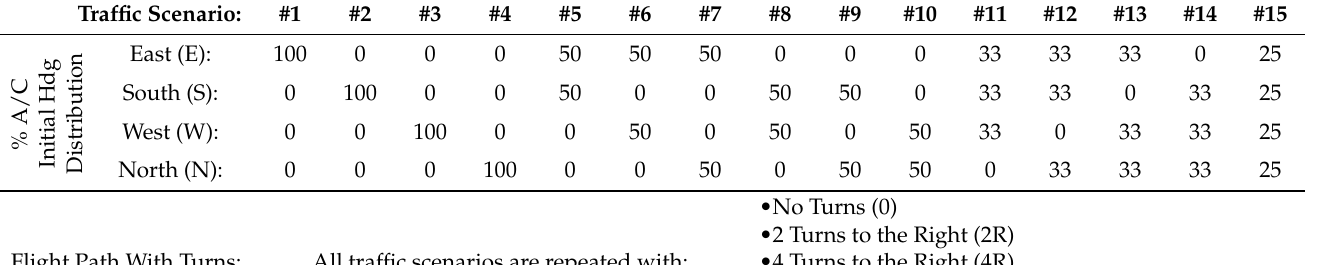
Table 2. Flight routes are defined as per the initial direction and the number of turns. The aircraft initial distribution defines, for each scenario, the percentage of flights starting in each initial direction. A total of 15 scenarios with different initial distributions were used. Each scenario was performed five times, with a different number and direction of